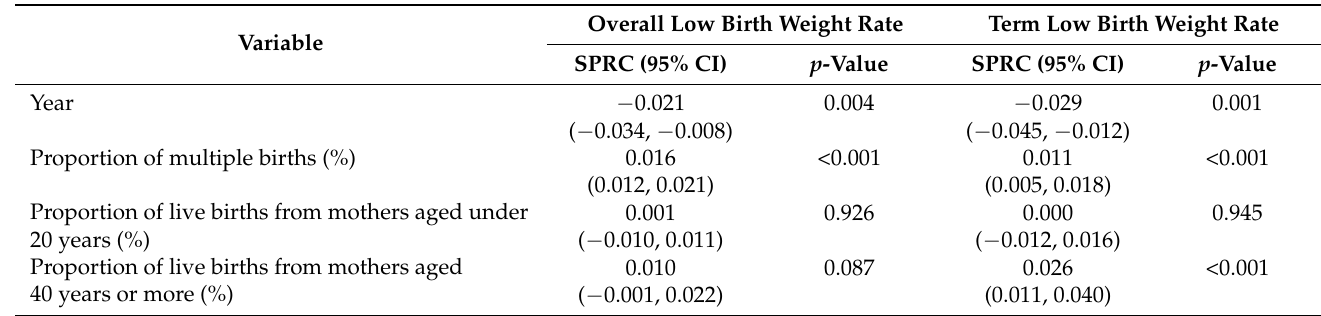
Table 6. Results of the regression analysis (N =